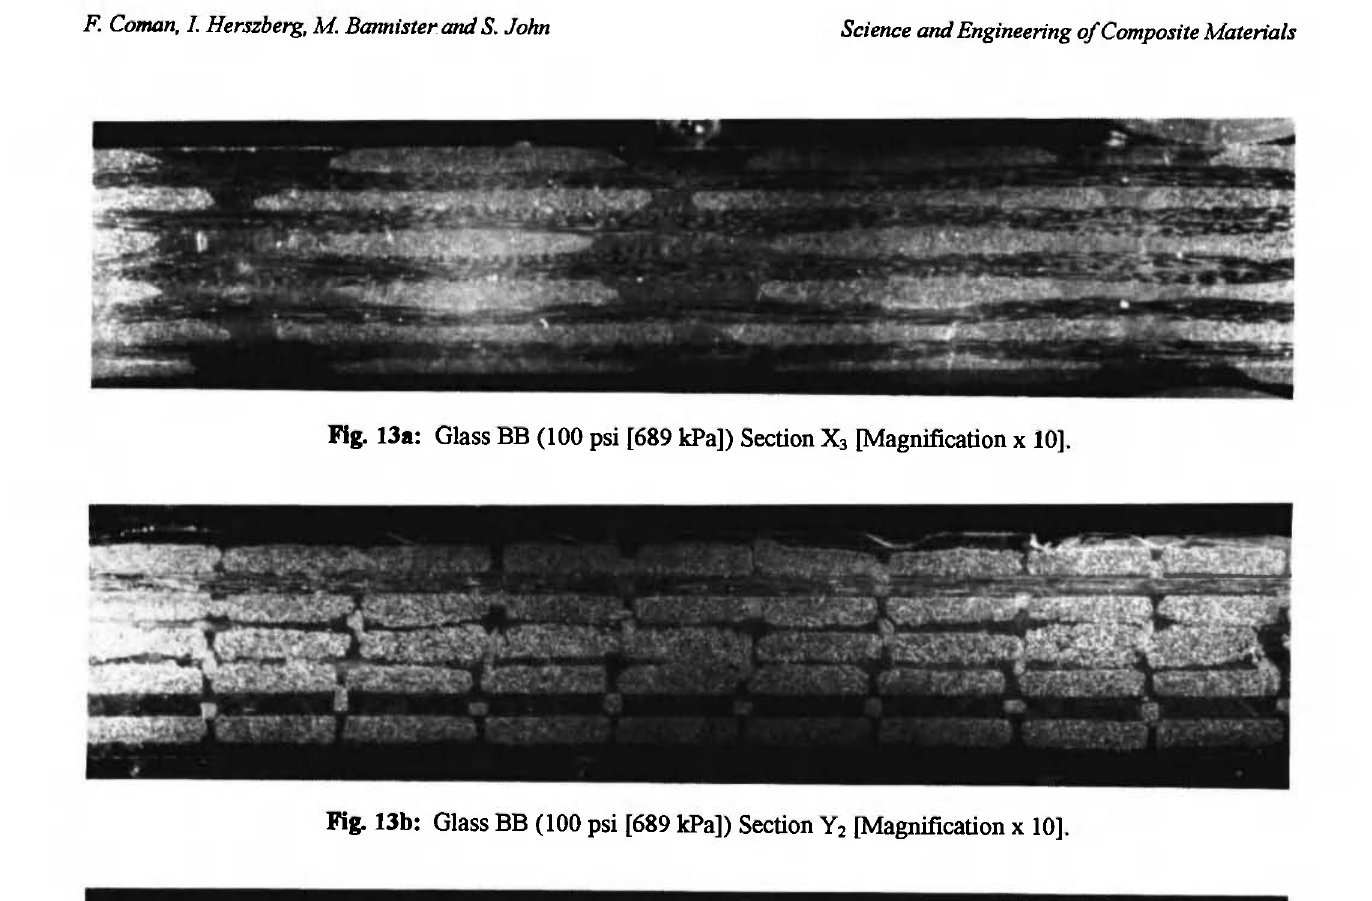
Fig. 14a: Polyester AA, Section Y